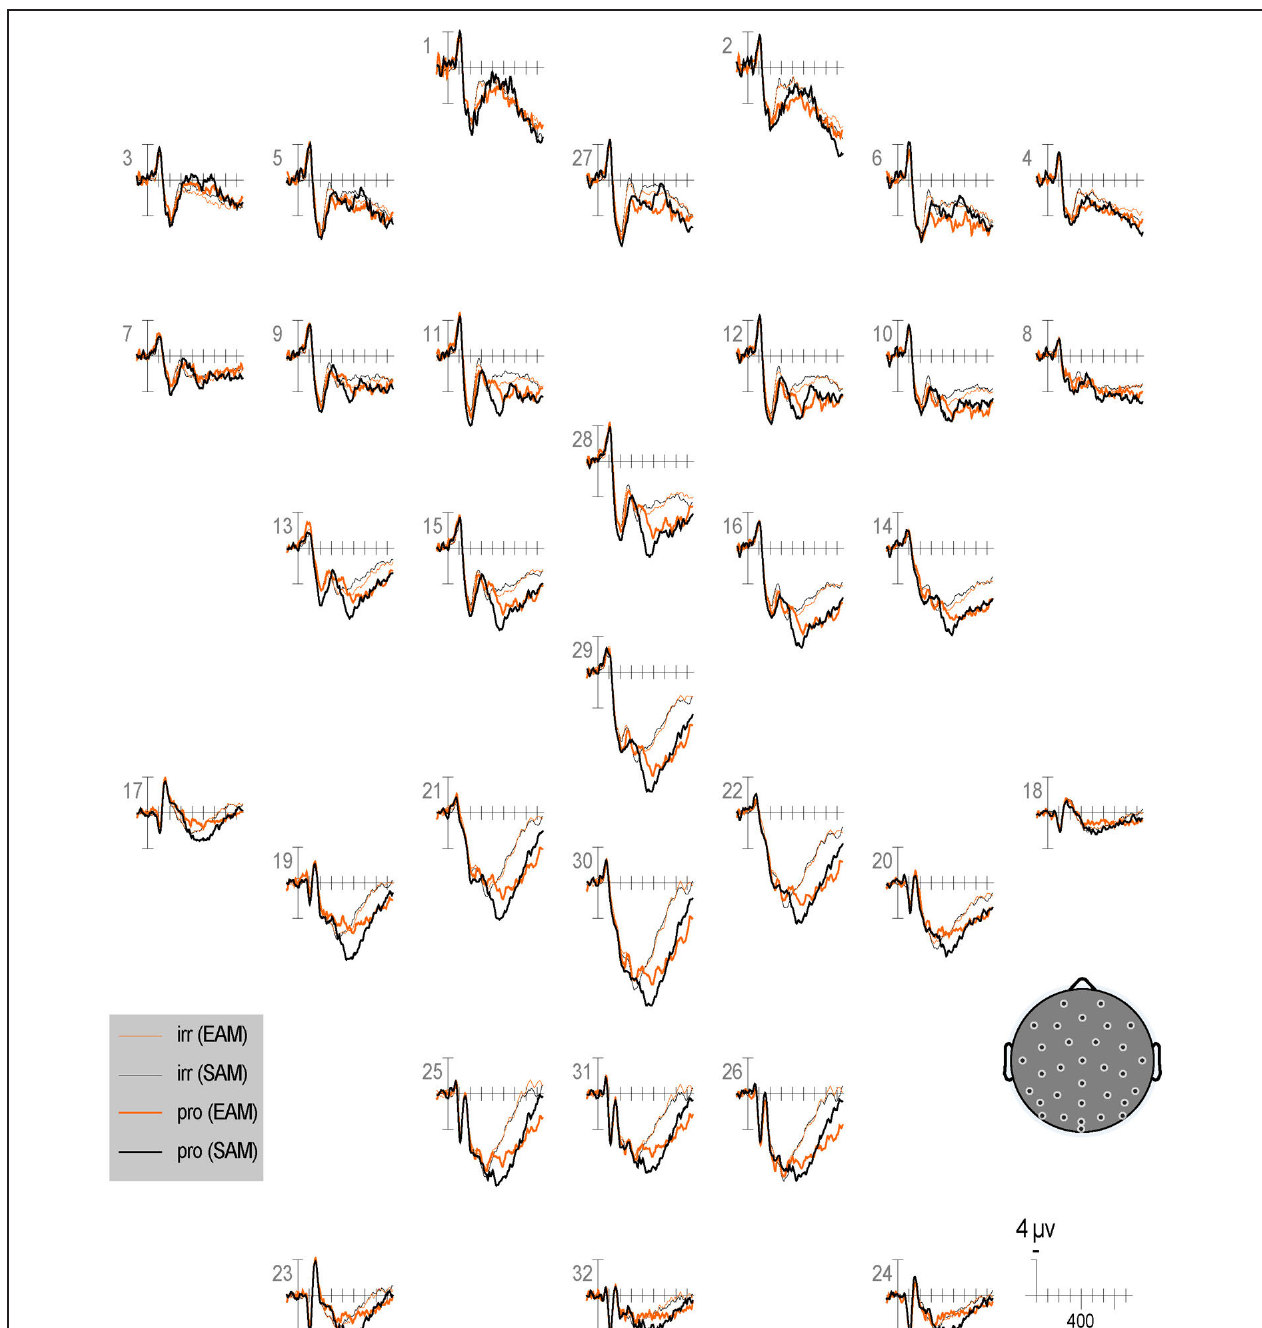
plotted between 100 and 900ms (at all scalp recording sites). ERPs are shown negative up and referenced to the average of the left and right mastoids. A diagram with the location of the recording sites is shown on the bottom